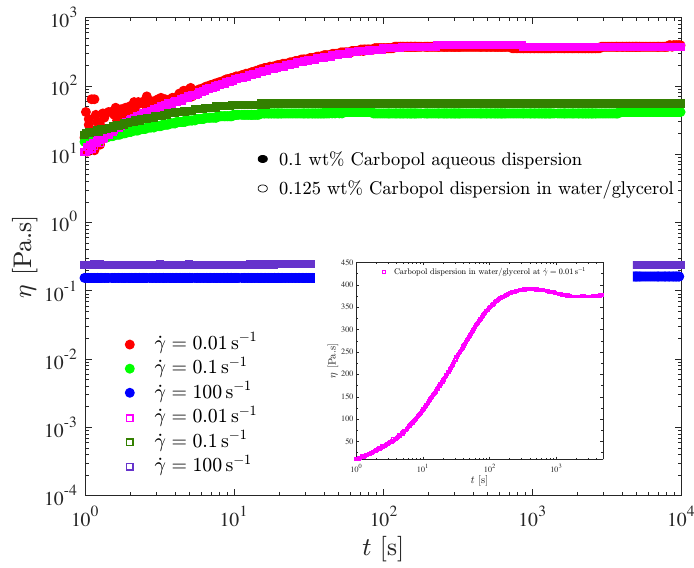
Figure 6. The constant shear rate test for the dispersions with the same yield